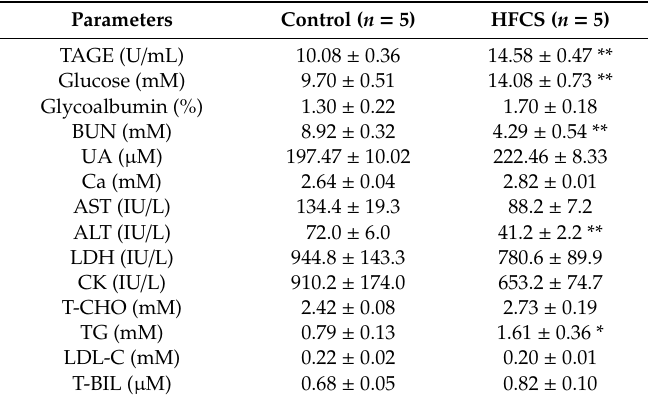
Table 2. Serum and plasma biochemistries in the HFCS group.